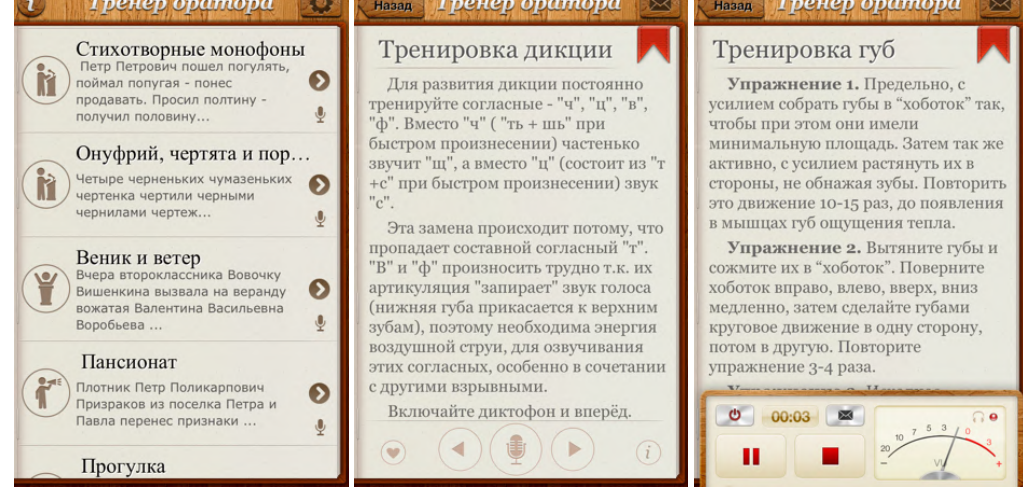
Figure 6: Speaker Coach App.